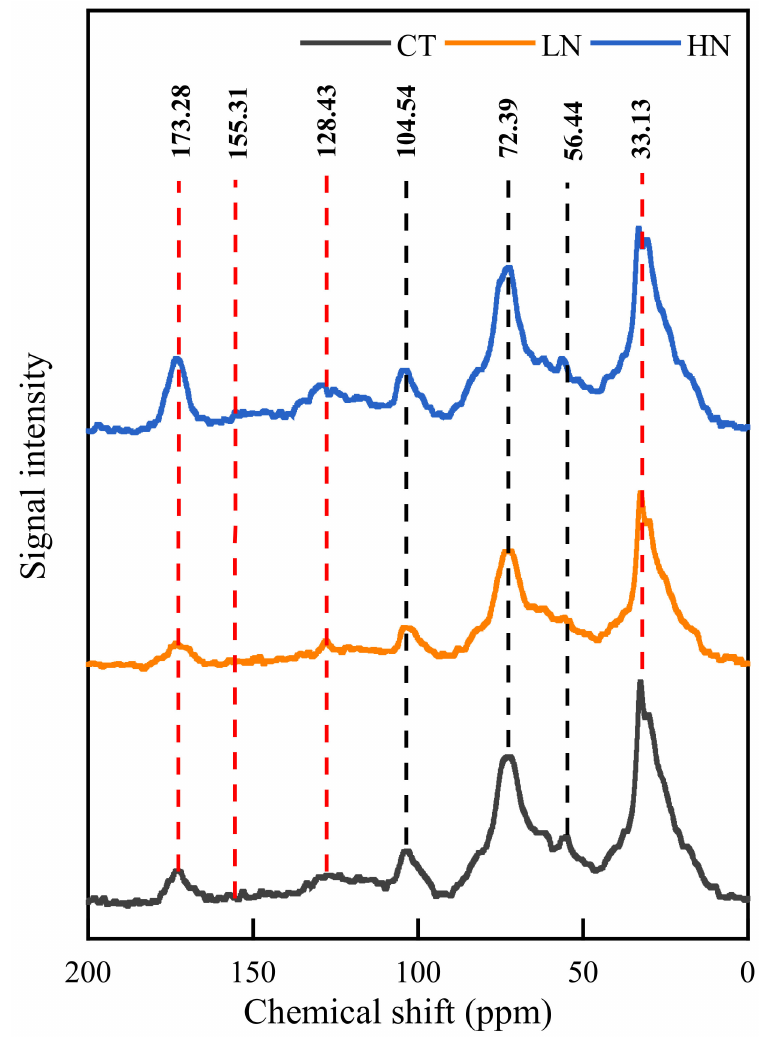
Figure 4. Solid-state 13 C nuclear magnetic resonance spectra of soil under di ff erent N addition treatments. The red dashed line indicates changes in the chemical shift